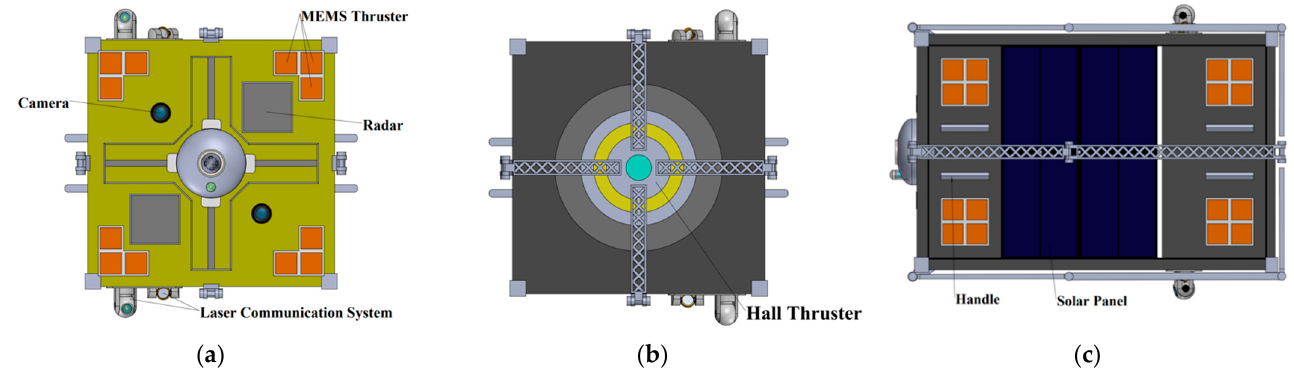
Figure 2. Three views of the servicing satellite in orthographic projection. ( a ) Front view, ( b ) back view, ( c ) side view.